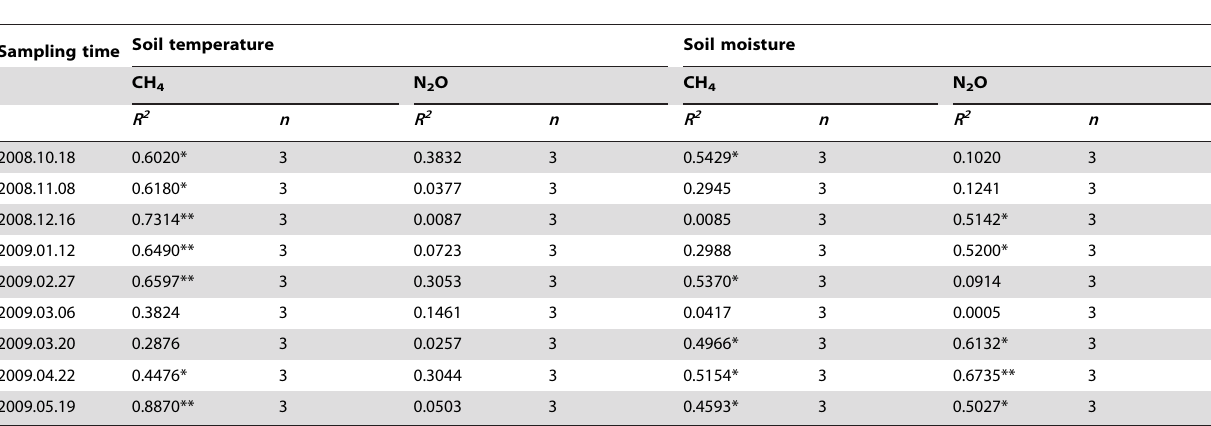
Table 2. Correlation analysis between changes in CH 4 and N 2 O with soil temperature and soil moisture per sampling time.